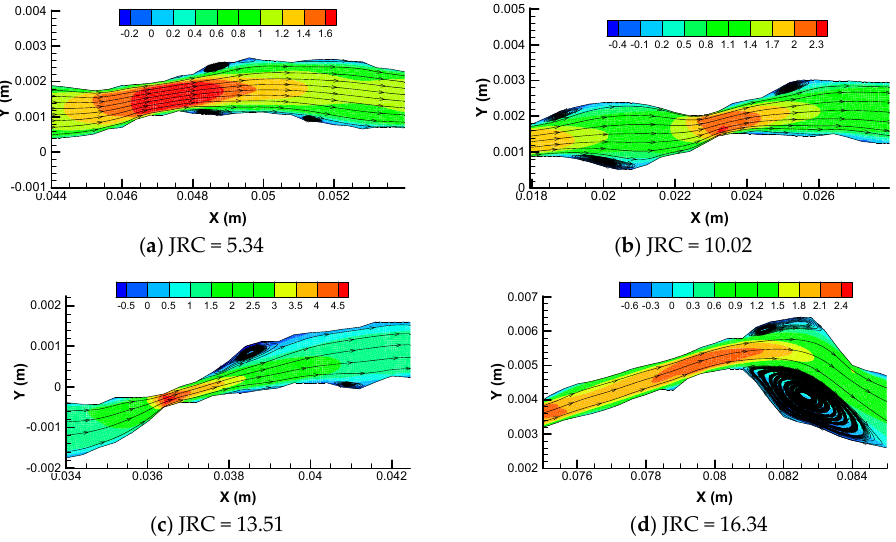
Figure 8. Eddy evolution with different JRCs, where Re = 1500 and d s = 2.0 mm.